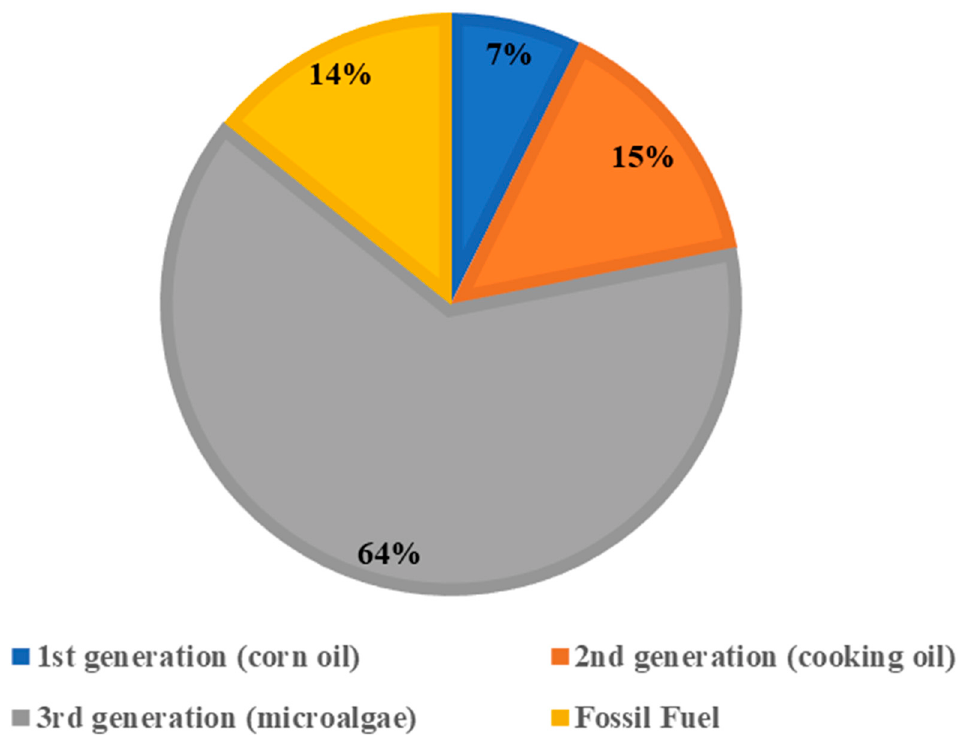
Figure 7. Economic comparison between first-, second-, and third-generations of biofuels and fossil fuels (data obtained from